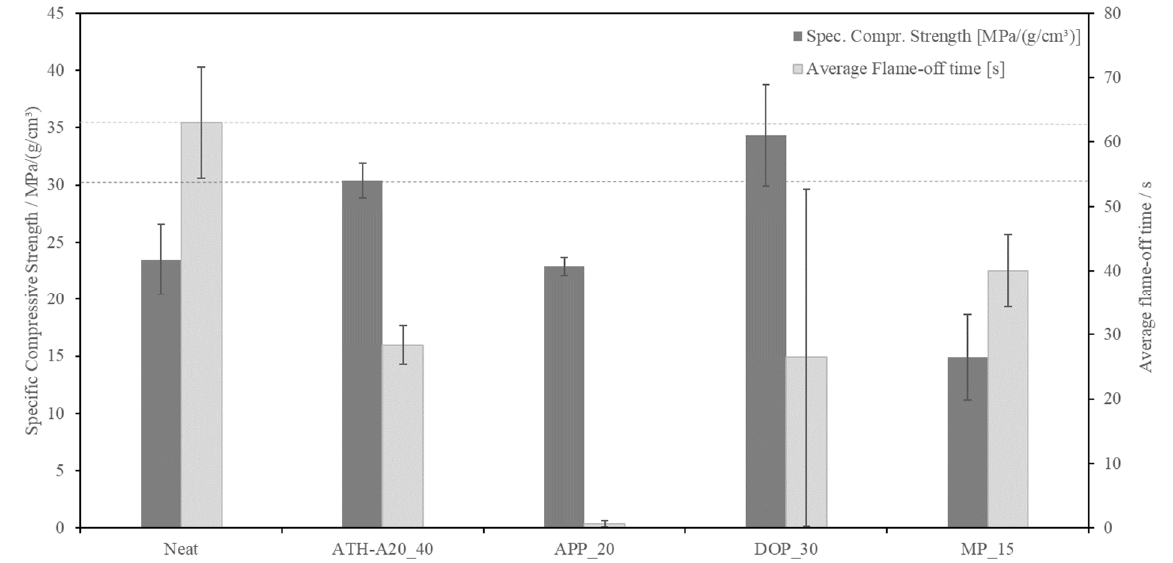
Figure 8. Average specific compressive strength (compressive strength normalized by the foam density), compression tests ref. to DIN EN ISO 844:2014-11, preload 1 N, test speed 1 mm/min, max. deformation 70% (dark grey) and average flame-off time in horizontal burn tests ref. to UL94 with reduced specimen size (light grey).